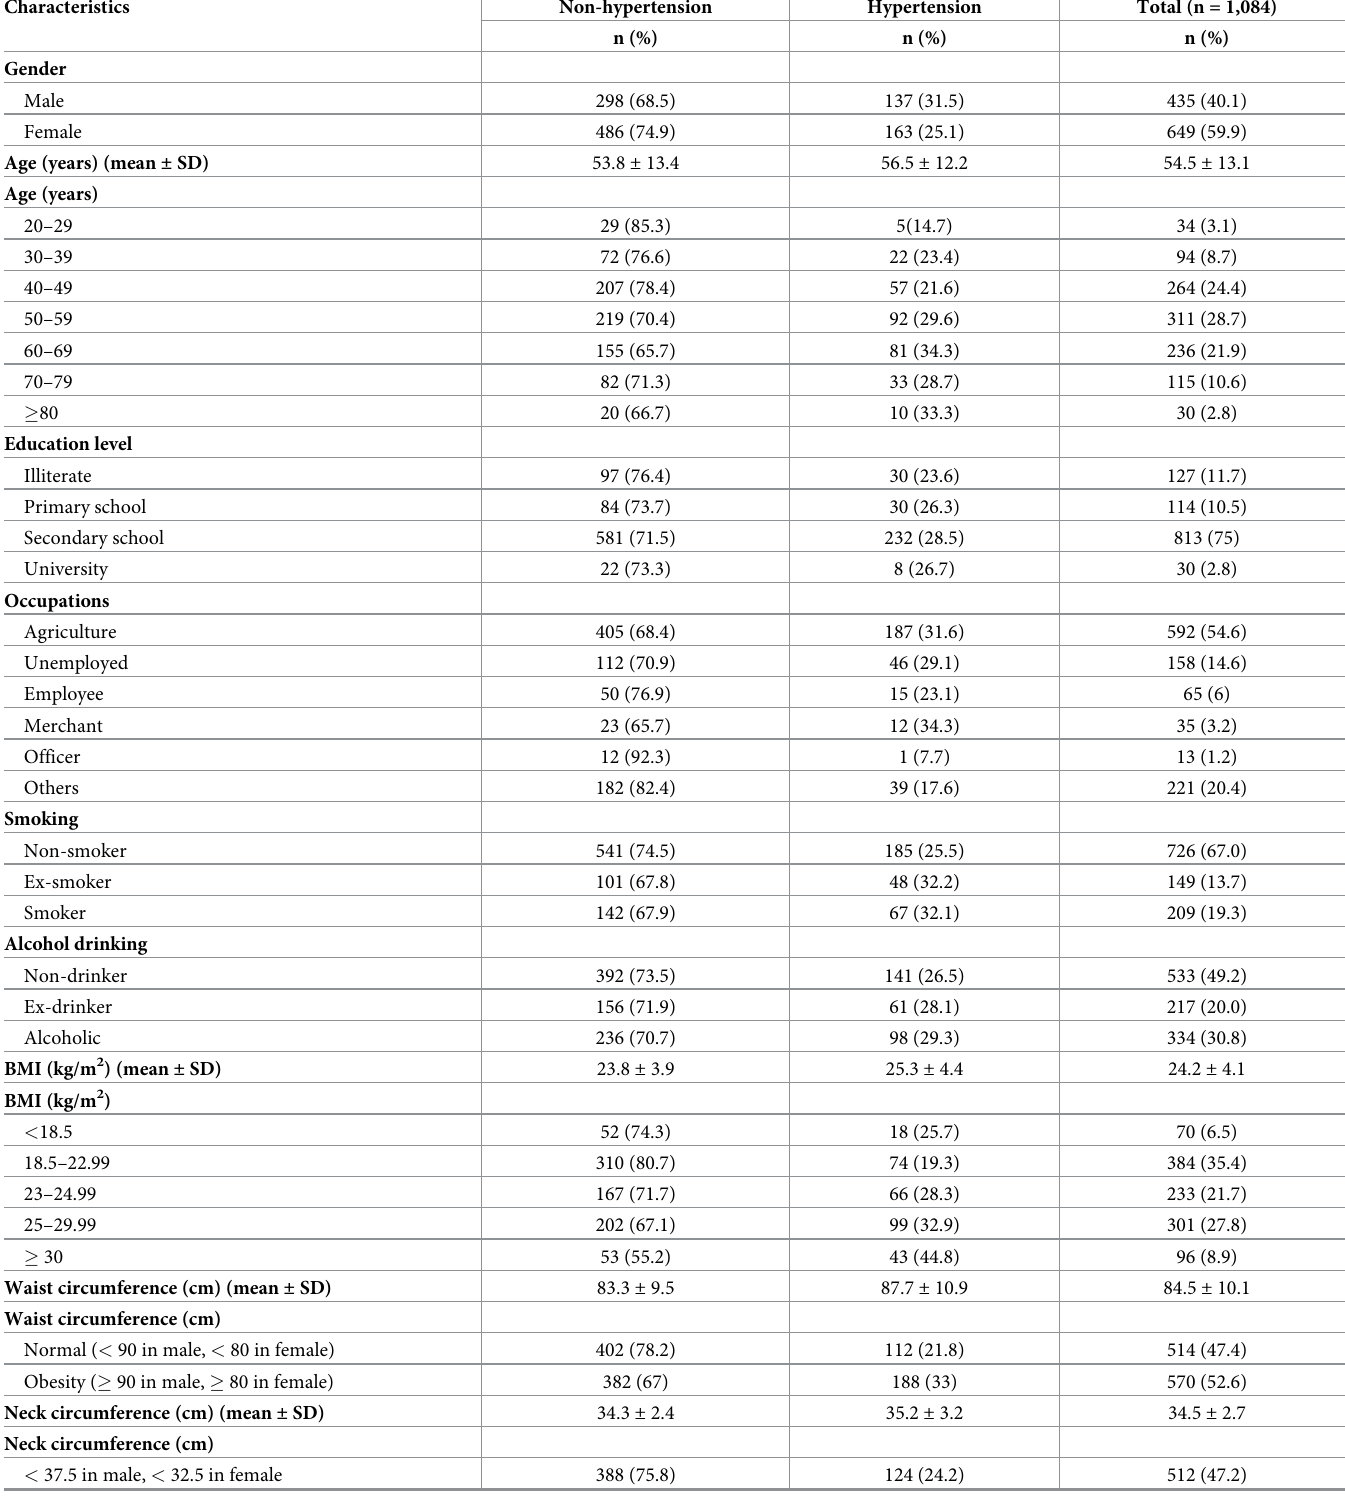
Table 1. General characteristics of participants enrolled into the